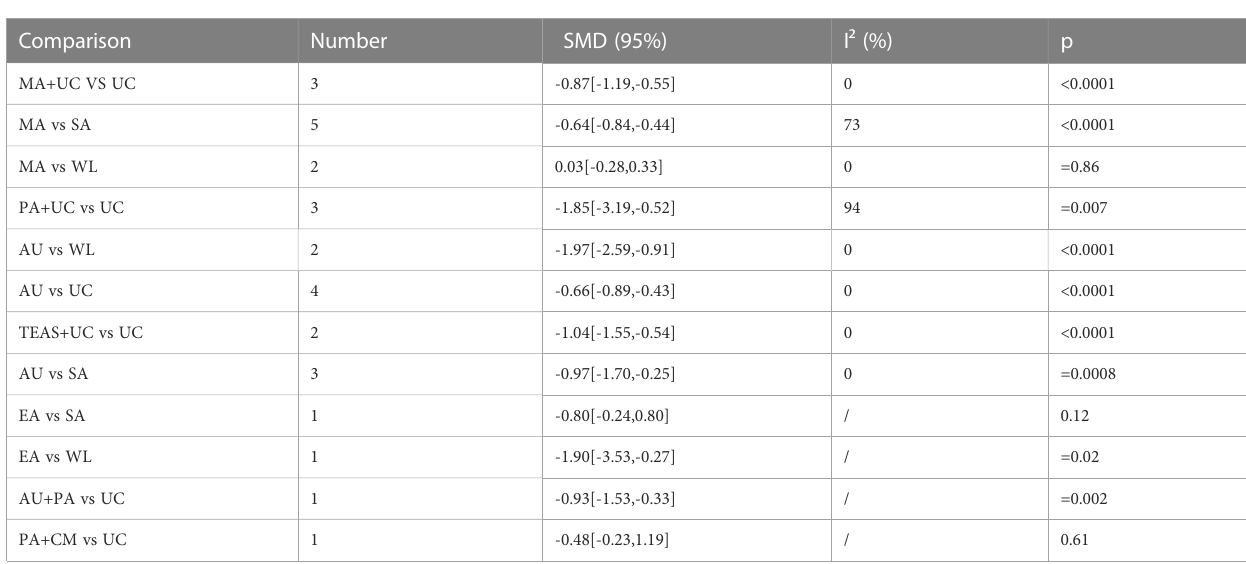
TABLE 2 Pairwise meta-analysis of